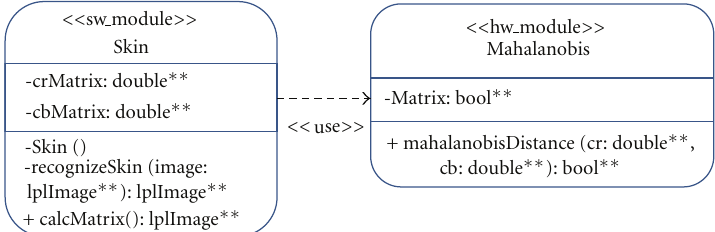
Figure 2: Example of architectural partitioning in UML-ESL.